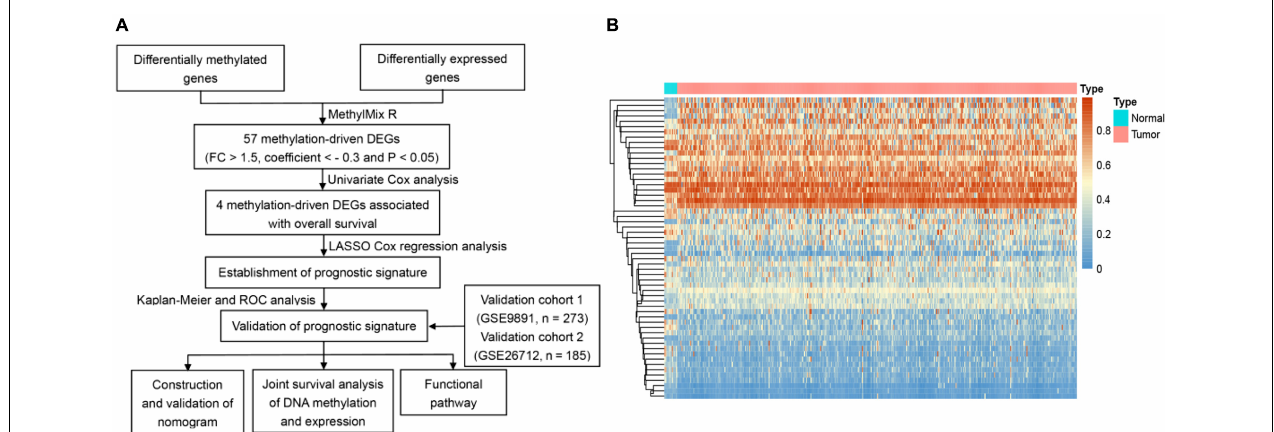
FIGURE 1 | Identification of methylated related genes and flowchart of the establishment of novel prognostic signature. (A) The flowchart of the establishment of novel prognostic risk model for patients with ovarian cancer (OC). (B) The heatmap plot of 57 methylation related differentially expressed genes (DEGs) in OC. The color change from blue to red in the heatmap illustrates the trend from low to high